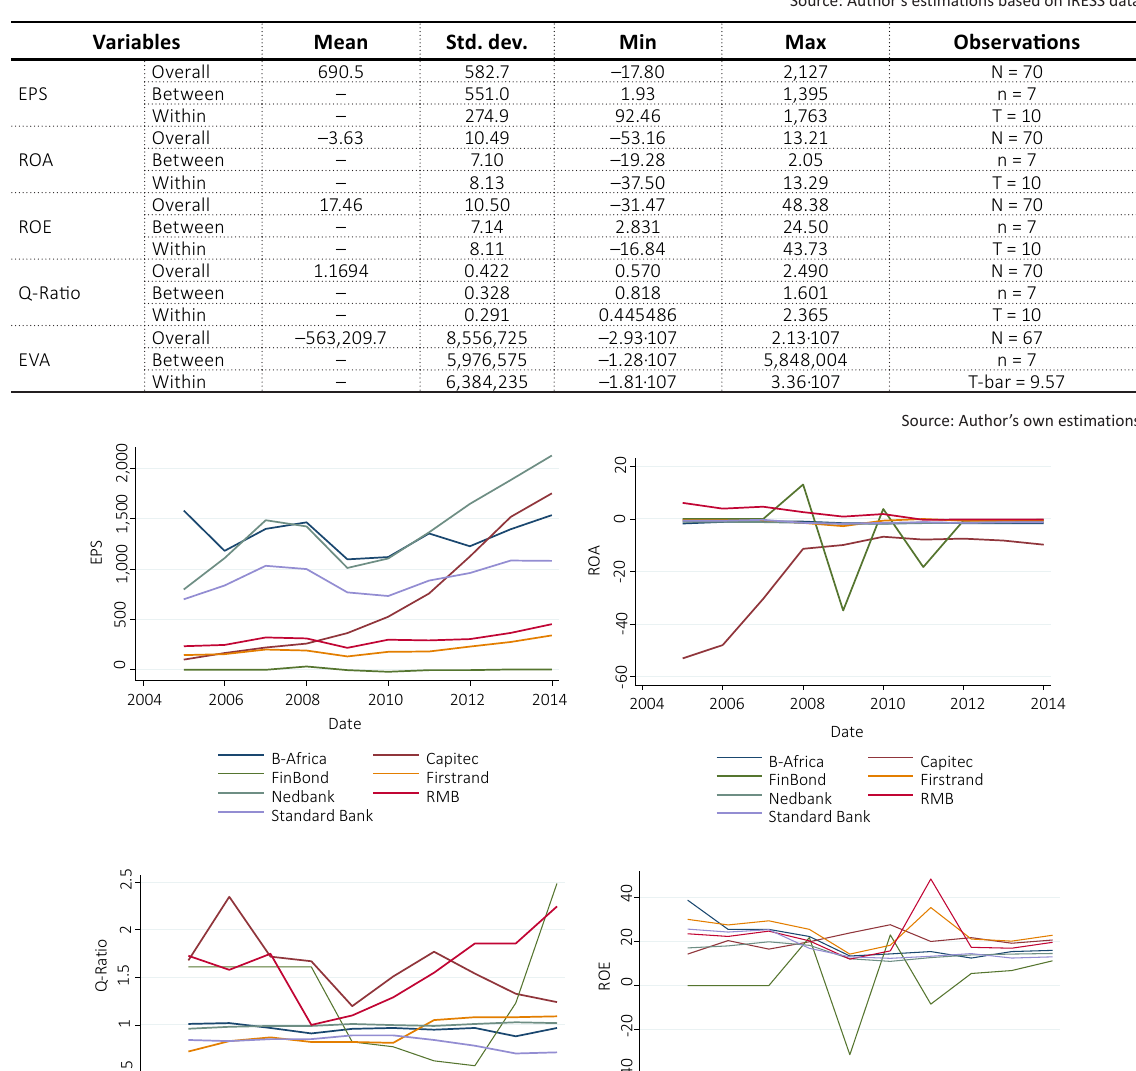
Table 1. Descriptive statistics of the panel data for financial performance of the banks